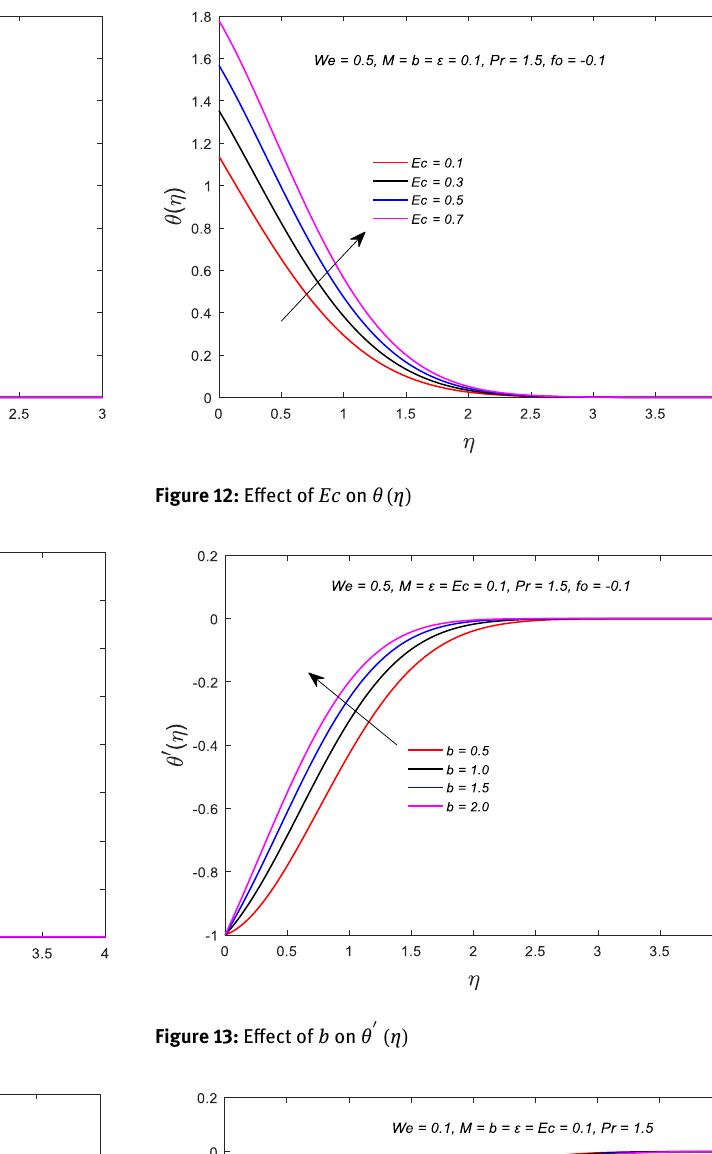
Figure 10: Impact of ϵ on θ ( η )